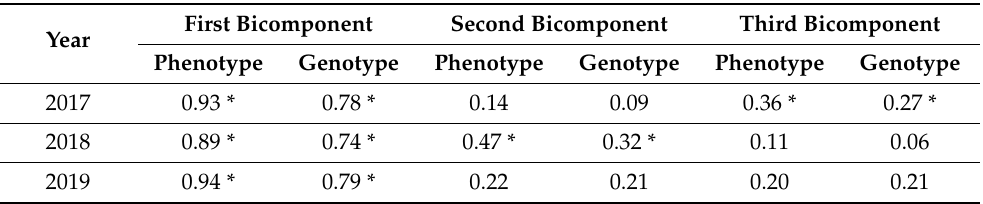
Table 4. Correlation coefficients for bi-components with phosphorus content in potato tuber starch for the crops of 2017, 2018, and